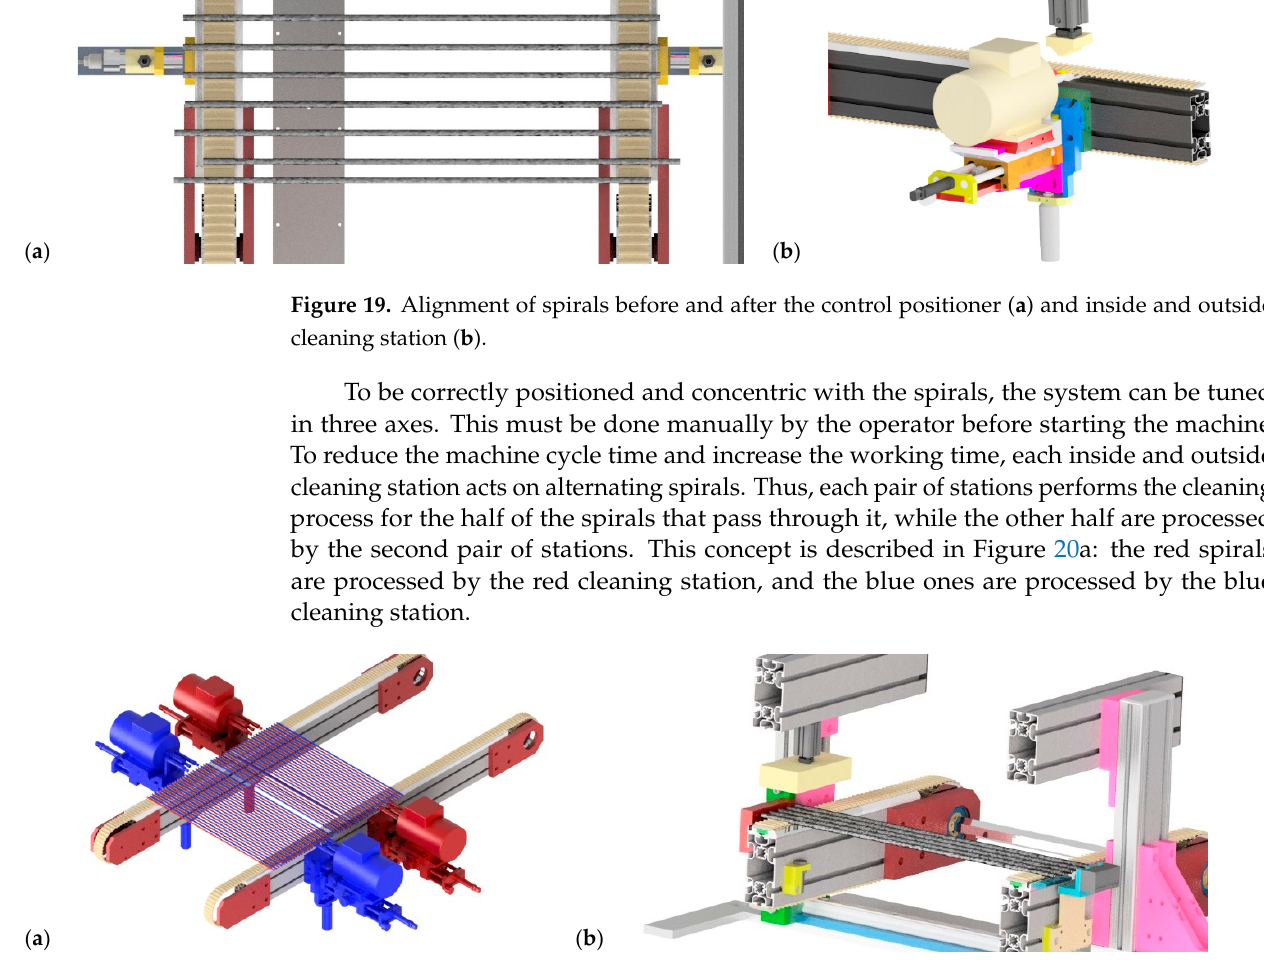
Figure 20. Processing of the spirals ( a ) and air cleaning station ( b ).